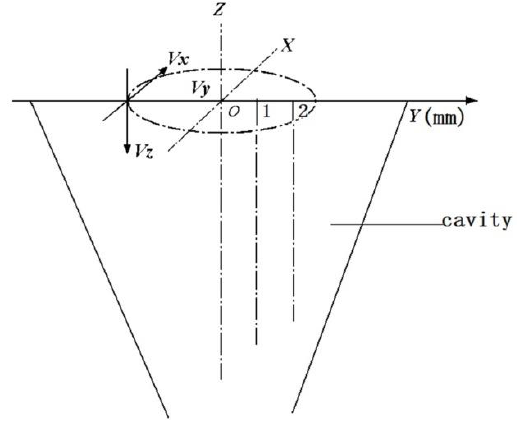
Figure 6. The definition of velocity in the pre-twister.